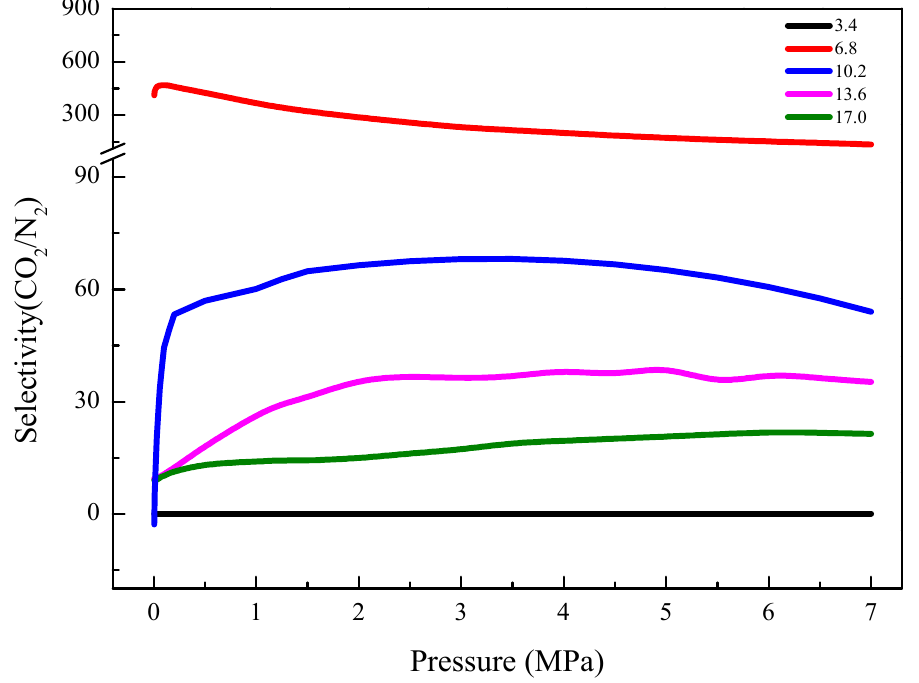
Figure 5. Selectivity of CO 2 over N 2 in N-MGNs at 298 K with equal ratio mixture ratios of CO 2 /N 2